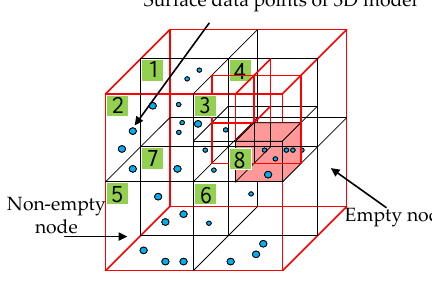
Figure 5. Schematic diagram of space partition.